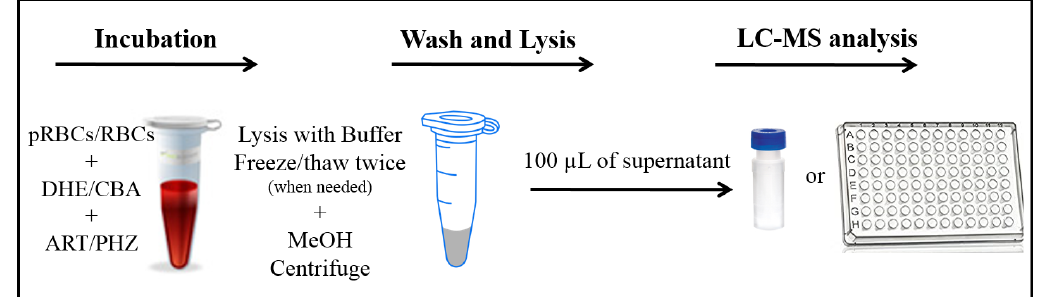
Figure 2. Summary of the sample the parasitized red blood cell (pRBC) or red blood cell (RBC) preparation or the LC – MS analysis . Note: pRBCs: Plasmodium infected red blood cells, MeOH: methanol, DHE: dihydroethydium, ART: artemisinin.